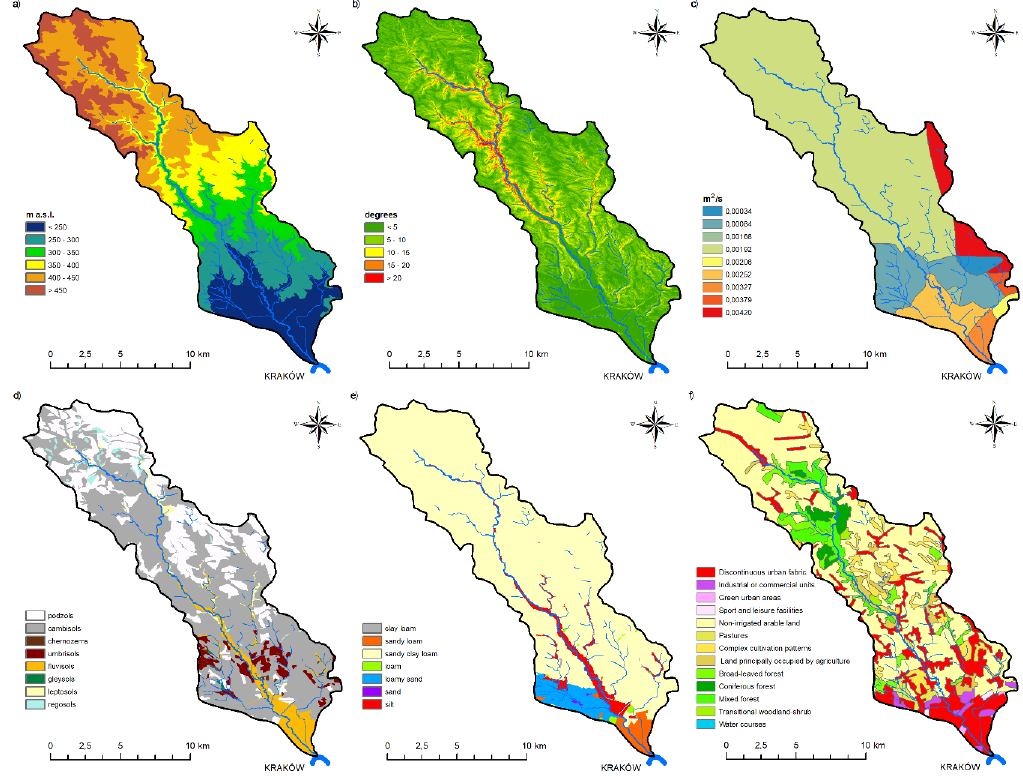
Figure 2. Landscape attributes of the Prądnik river basin: ( a ) hypsometry; ( b ) slope inclination; ( c ) bedrock transmissivity; ( d ) soil types; ( e ) soil texture; ( f ) land use/landcover (CLC 2018).